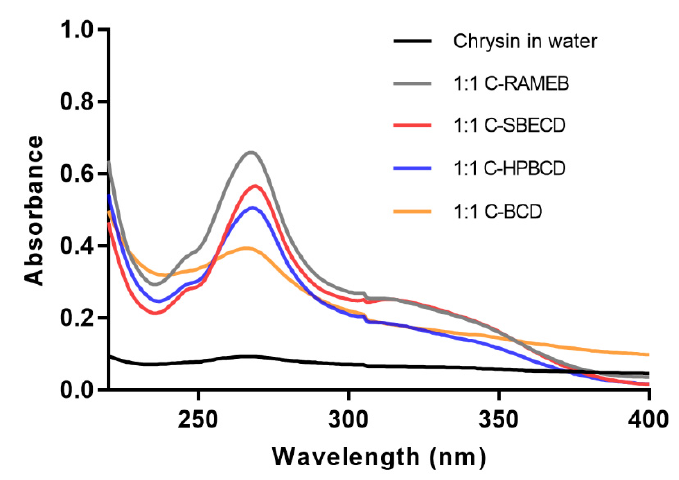
Figure 2. Representative UV spectra of chrysin–cyclodextrin complexes in water. Concentration values of dissolved chrysin are shown in Table 1.